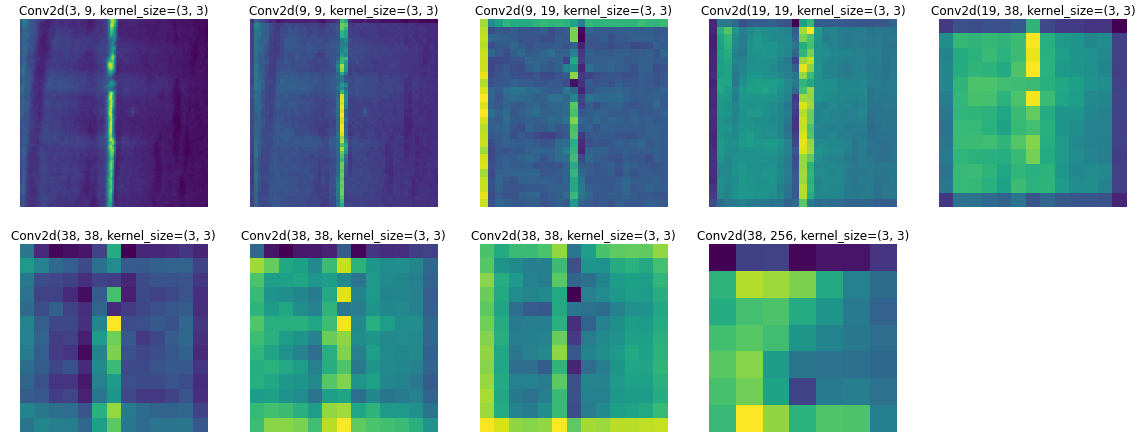
Figure 10. Convolutional layer visualization for RepVGG networks.